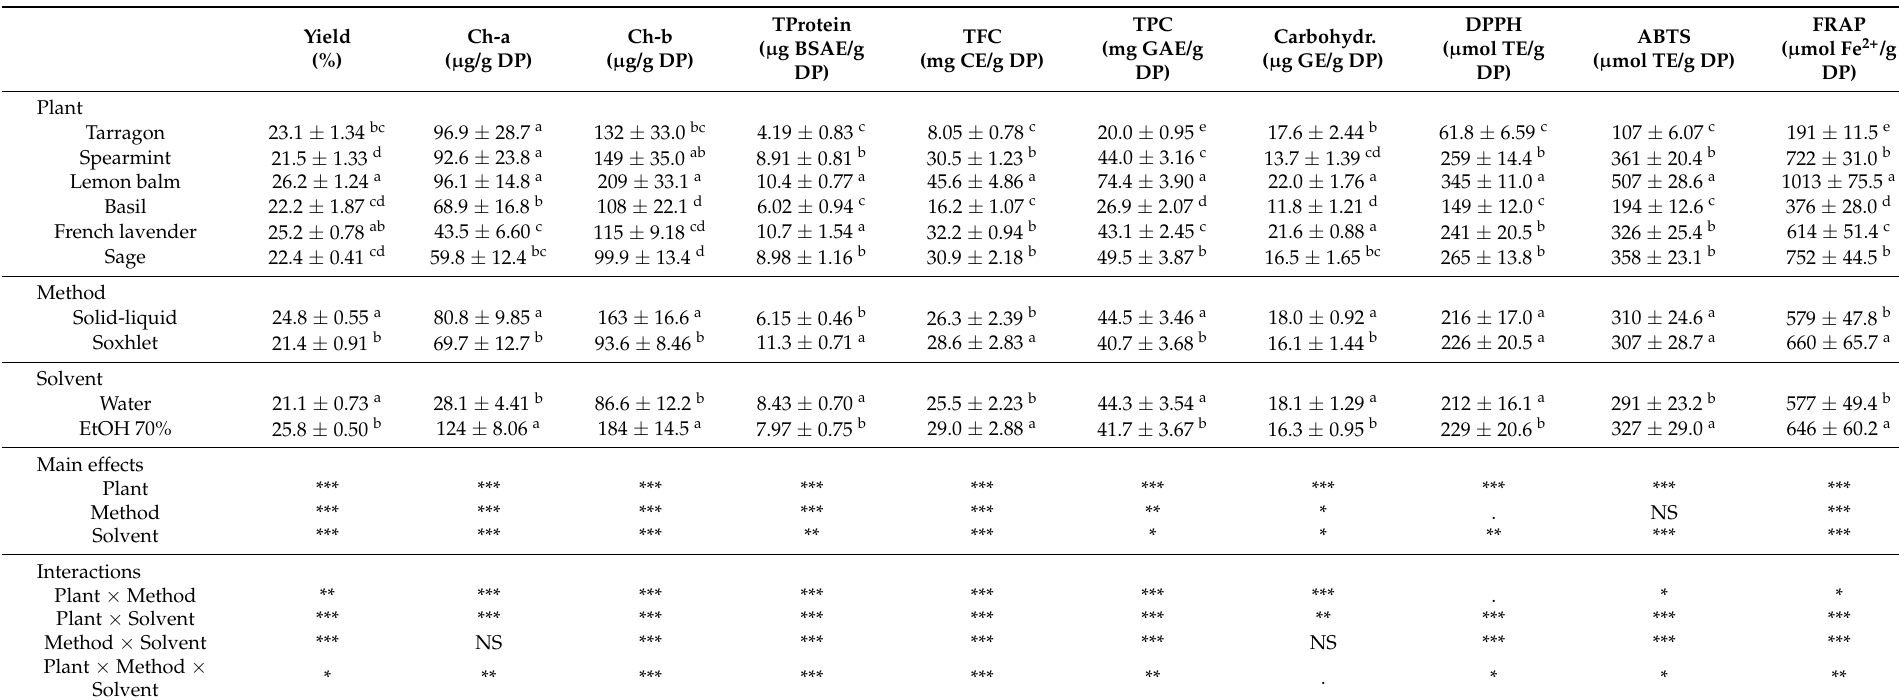
Table 1. Groupwise summary statistics (mean ± standard error) by plant, method, and solvent, for each chemical characterization and antioxidant assay, and significance of the main effects and interactions of the models.